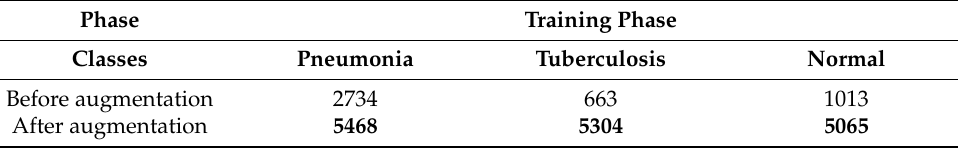
Table 2. Method of data augmentation of the X-rays for pneumonia and tuberculosis data set to balance the data